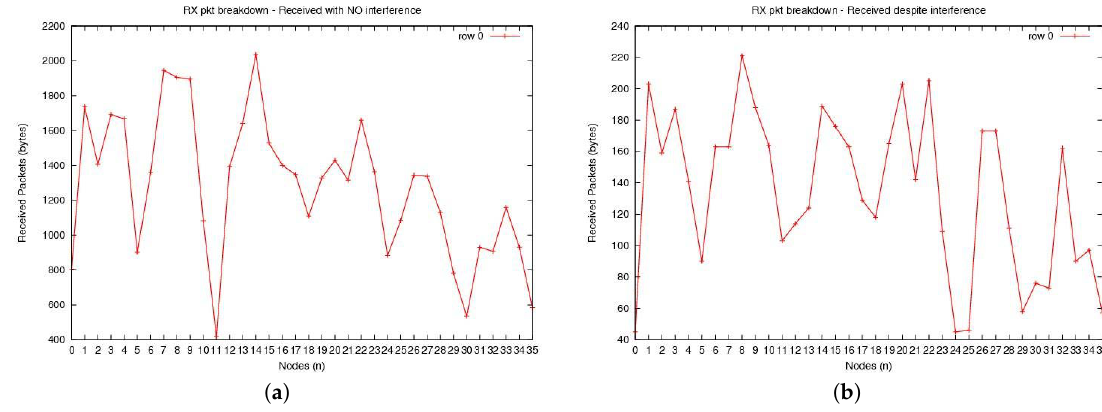
Figure 6. The number of packets received ( a ) without interference, and ( b ) with interference.